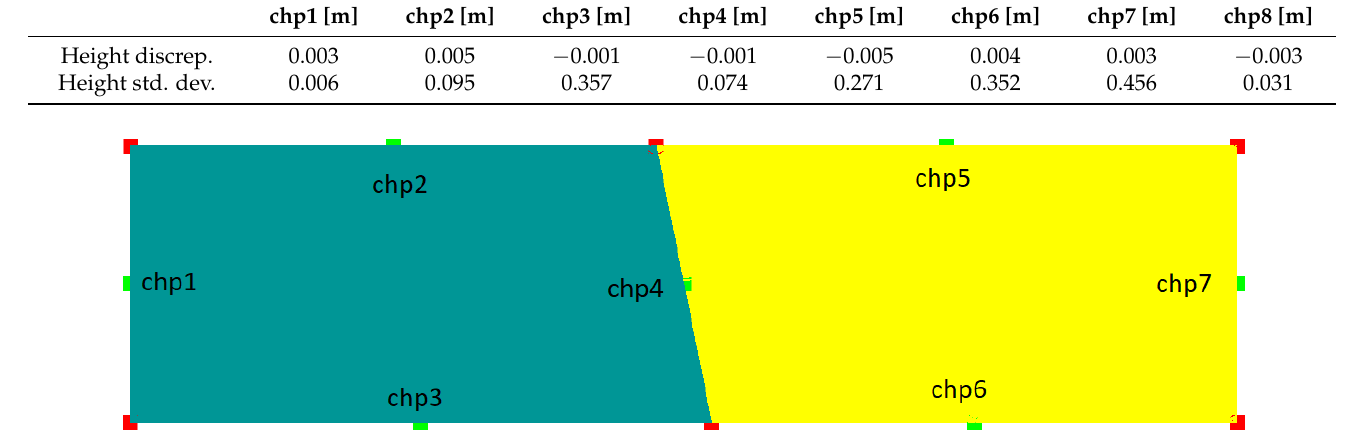
Figure 8. Top view of two segments generated after correction process with red GCPs and green check points distribution.